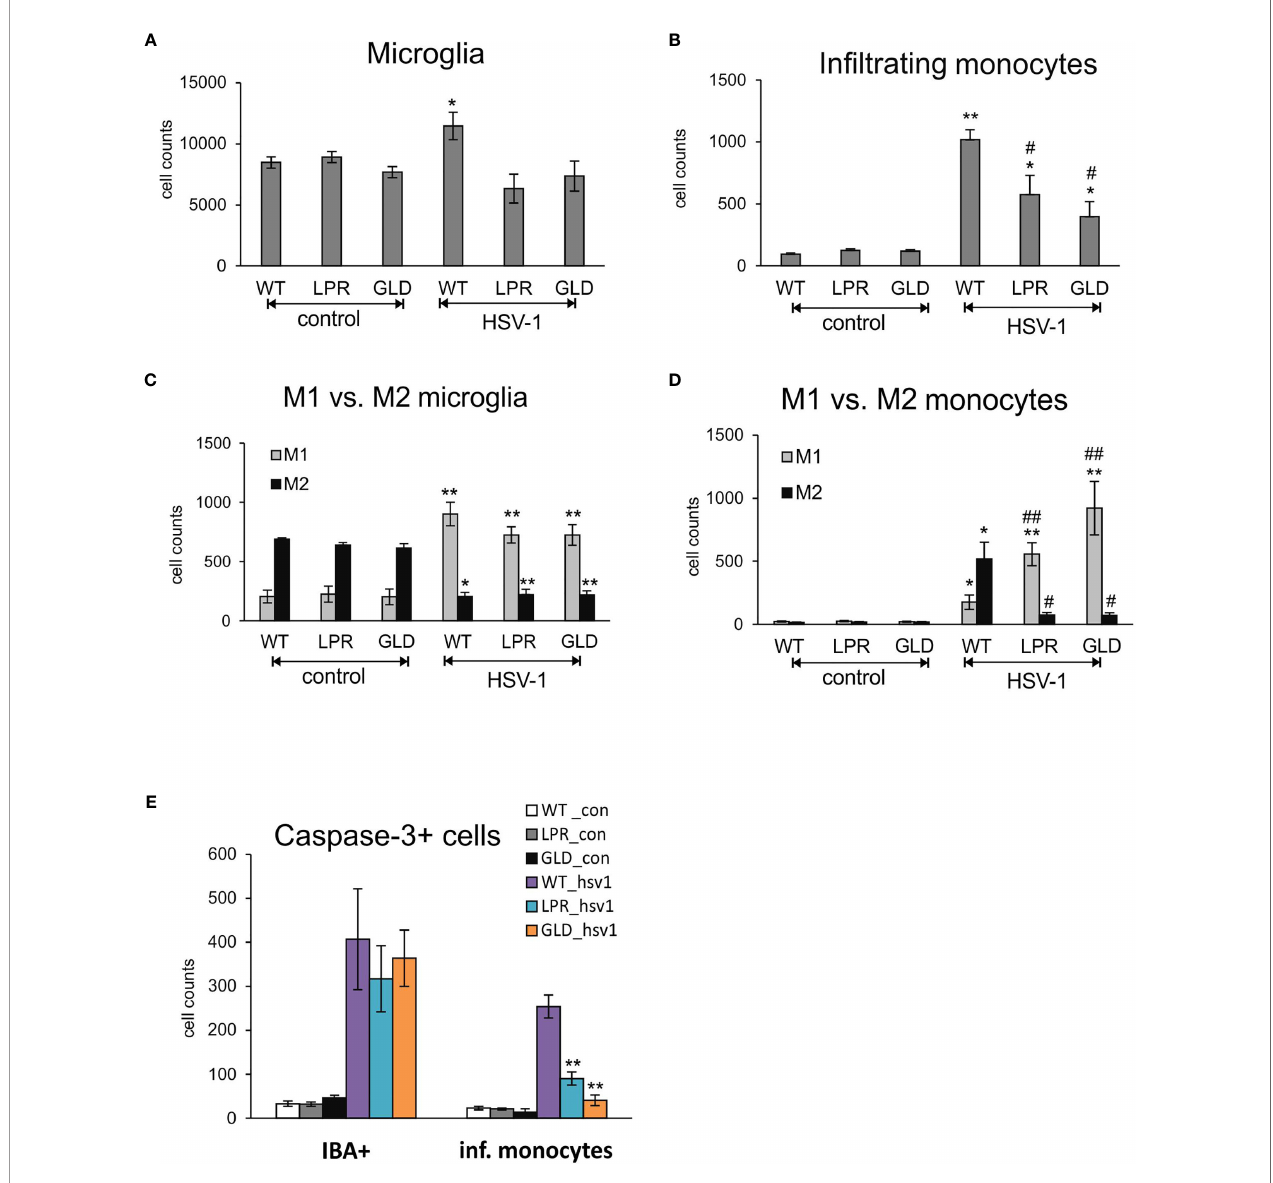
FIGURE 5 | Fas/FasL pathway regulated activation of microglia/monocytes in HSV-1 infected brains. (A) microglia cell counts; (B) monocyte cell counts in wild-type (C57BL/6), Fas-de fi cient (lpr) and FasL-de fi cient (gld) mice at 8 d p.i. measured by fl ow cytometry in brain tissue homogenates. M1/M2 phenotype of microglia (C) and in fi ltrating monocytes (D) in the homogenates prepared as above. (E) Numbers of microglia cells (IBA-1+) and in fi ltrating monocytes positive for active form of caspase-3 in brains of wild-type, lpr and gld mice at 8 dp.i. Data were presented as mean ± SEM, N = 7. Data analysis was performed by comparing Fas-de fi cient (lpr) and FasL-de fi cient (gld) groups with wild-type (C57BL/6) mice. **p ≤ 0.001, *p ≤ 0.05, # compared to uninfected control, while ## indicates p ≤ 0.01 and # p ≤ 0.05 compared to infected wild-type